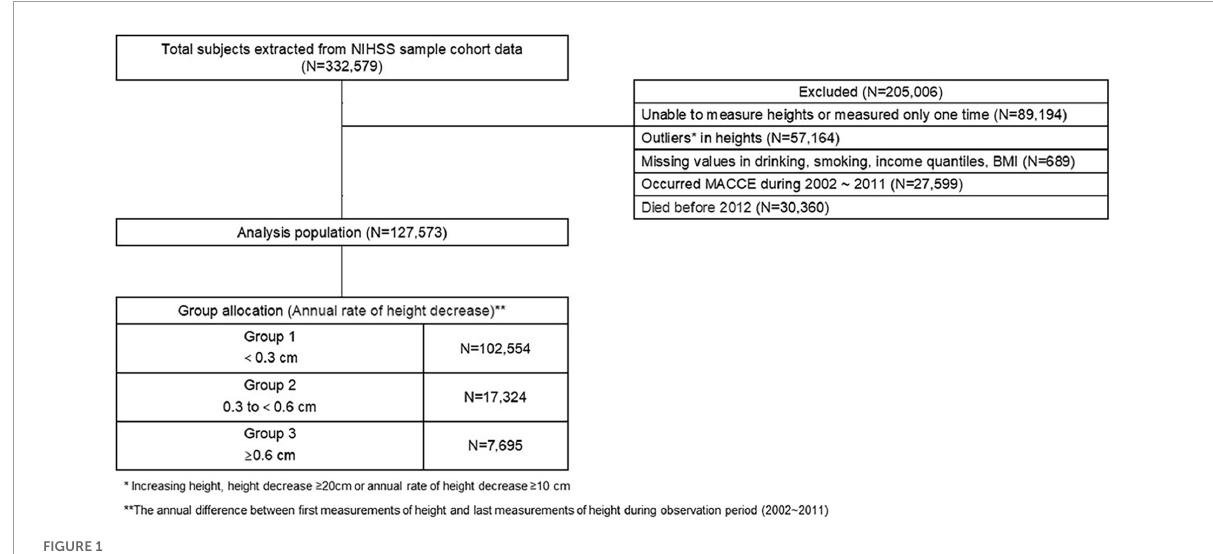
FIGURE1 A flow diagram of the study